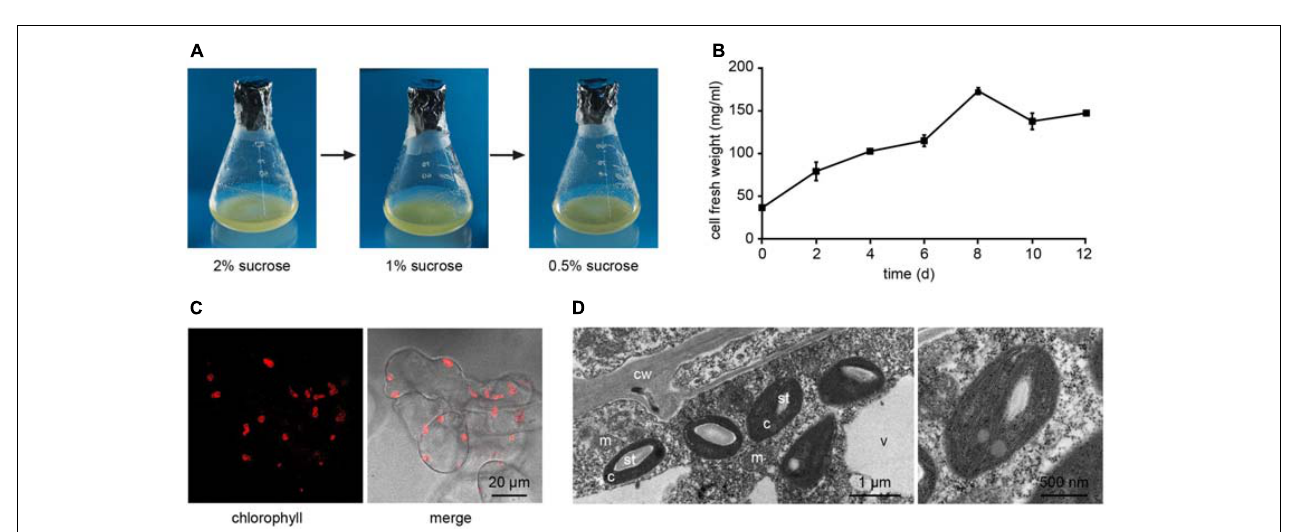
FIGURE 2 | Establishment of Arabidopsis photosynthetic cell suspension cultures. (A) Suspension-cultured cells were maintained in MS culture medium containing 0.25 µ g/ml BAP and 0.5 µ g/ml 2,4- D , and gradually reduced sucrose concentrations to stimulate the photosynthetic activity. (B) Growth curve of the photosynthetic cell suspension culture, after three sub-culturing steps in 0.5% sucrose-containing medium. Data are the means ± SE of three independent replicates for each time point. (C) Confocal microscopy analysis confirmed the presence of chloroplasts as functional type of plastids in the cell suspension cultures. (D) Ultrastructure of chloroplast-containing suspension-cultured cells. c, chloroplasts; cw, cell wall; m, mitochondria; st, starch; v, vacuole. In the image on the right the magnification of a chloroplast is shown.